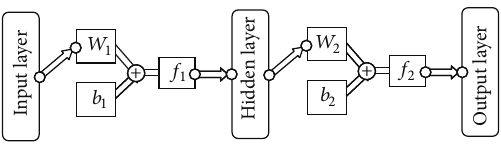
Figure 4: Flow chart of BP neural